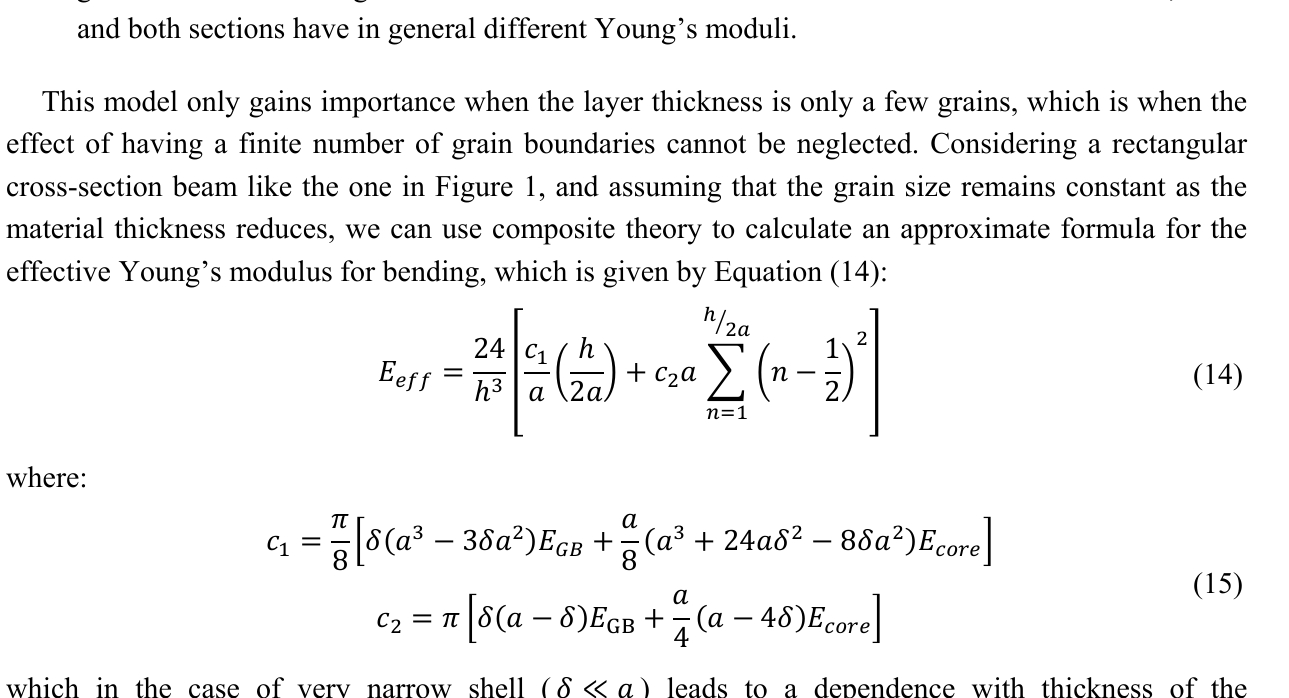
Figure 3. Grain Boundary Theory (GBT). Schematic showing the nanoscopic view of a grained material. Each grain has a diameter (cid:1853) and a thin shell around them with thickness (cid:2012) , and both sections have in general different Young’s